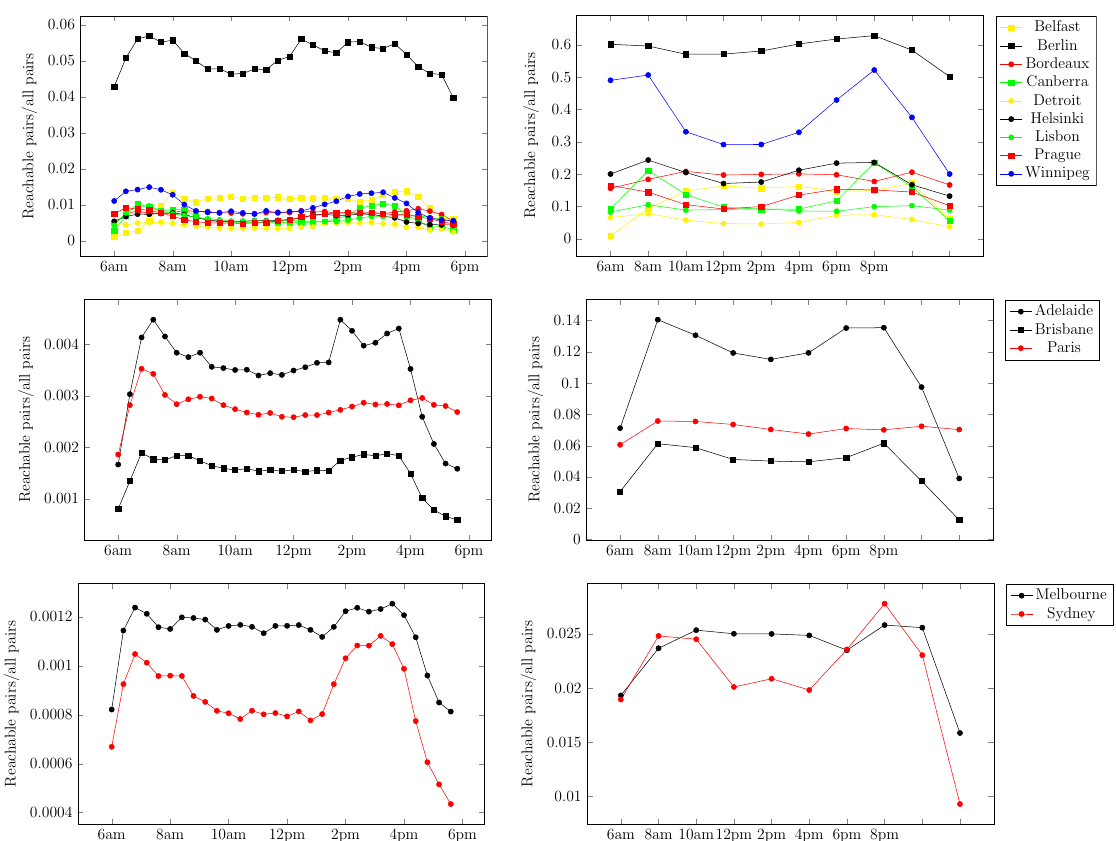
Figure 7. The comparison of the reachability diagrams with 30 intervals of 30 min each ( left ), and with 10 intervals of 90 min each ( right ) of the 25 public transport networks.